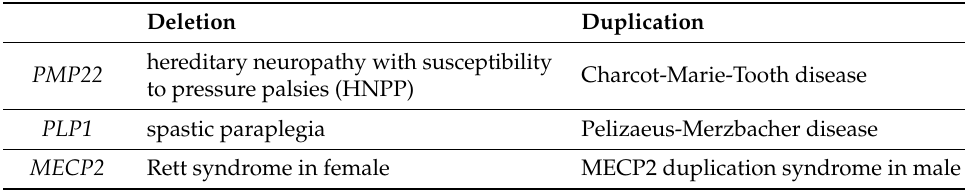
Table 2. The genes with different phenotypes in deletions and duplications.